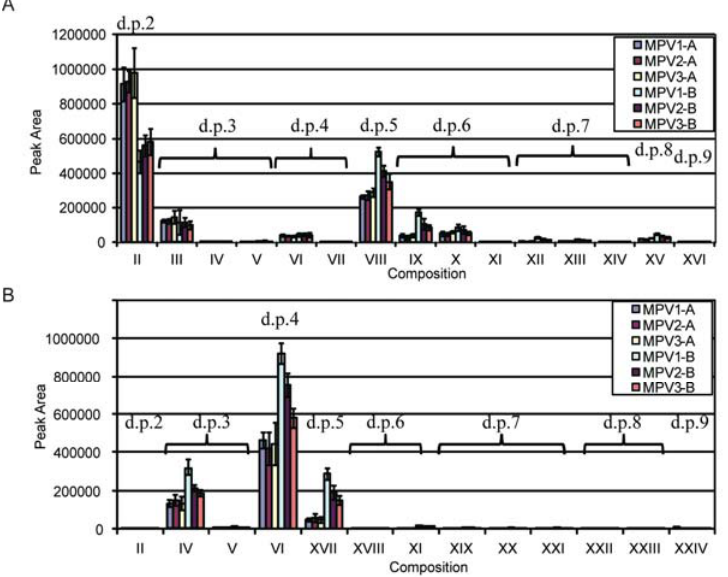
Figure 2. ( a ) Graphical representation of differences in the quantities of oligosaccharide products of switchgrass (SG) structural xylan from each maturity and xylan class from T. viride endo-xylanase enzymatic end-point digestion. ( b ) Graphical representation of differences in the quantities of oligosaccharide products of SG structural xylan from each maturity and xylan class from Celluclast end-point